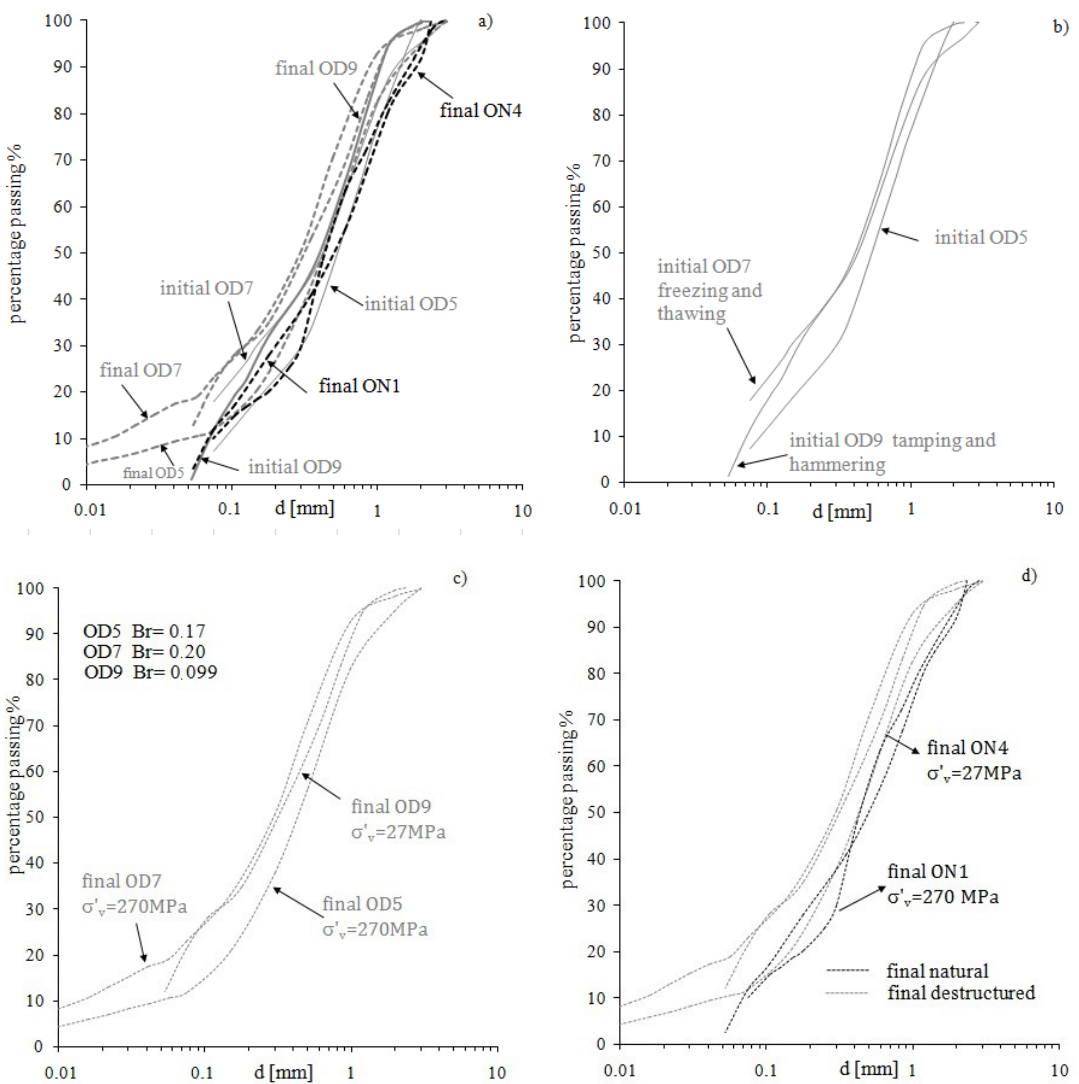
Figure 4. Particle size distributions (PSD) in oedometer tests. ( a ) Initial and Final PSD; ( b ) Initial PSD for destructured samples with different methods; ( c ) Influence of stress level on final PSD for destructured samples and relative breakage Br; ( d ) Final PSD for natural and destructured samples.